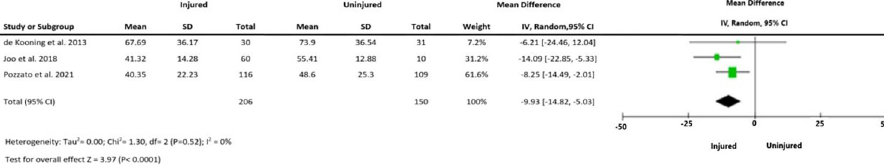
Fig 3. Outcome 2: Difference in SDNN (ms) between injured and uninjured